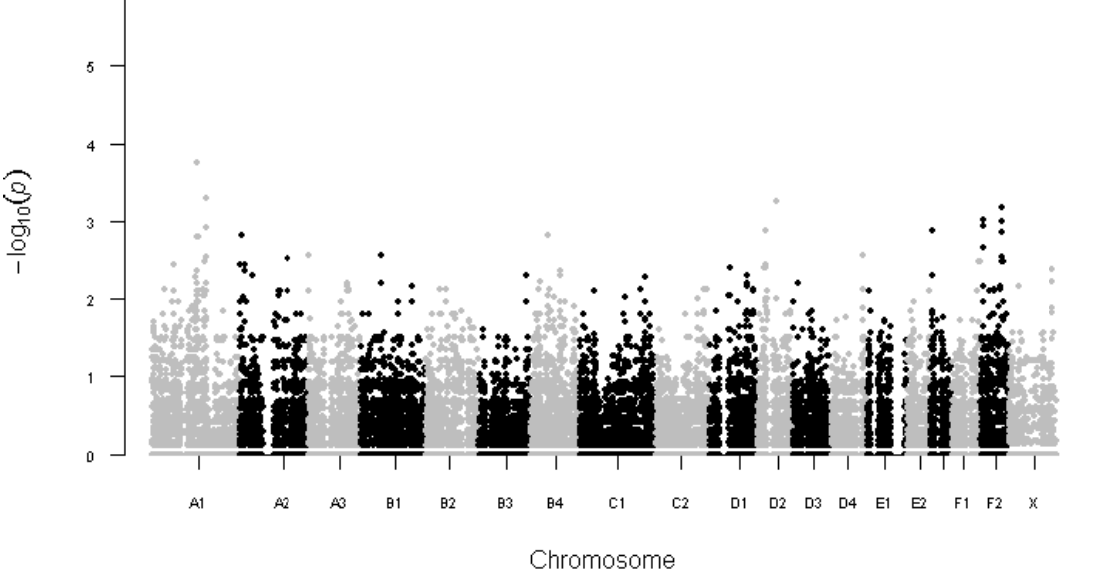
Figure 1. Manhattan plot of the p -values obtained with Fisher’s exact tests. The genome-wide significance (red line) is set at 1.3 × 10 − 6 (=0.05/37,595 tests).